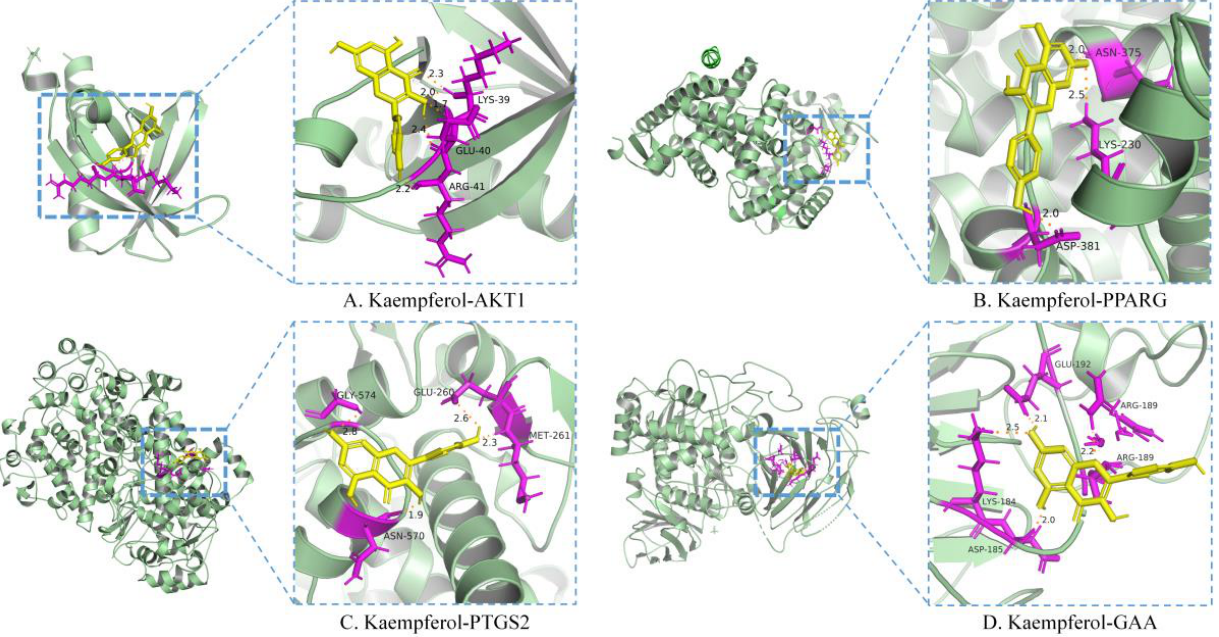
Figure 4. Molecular docking of the active ingredient and potential target by Autodock software.